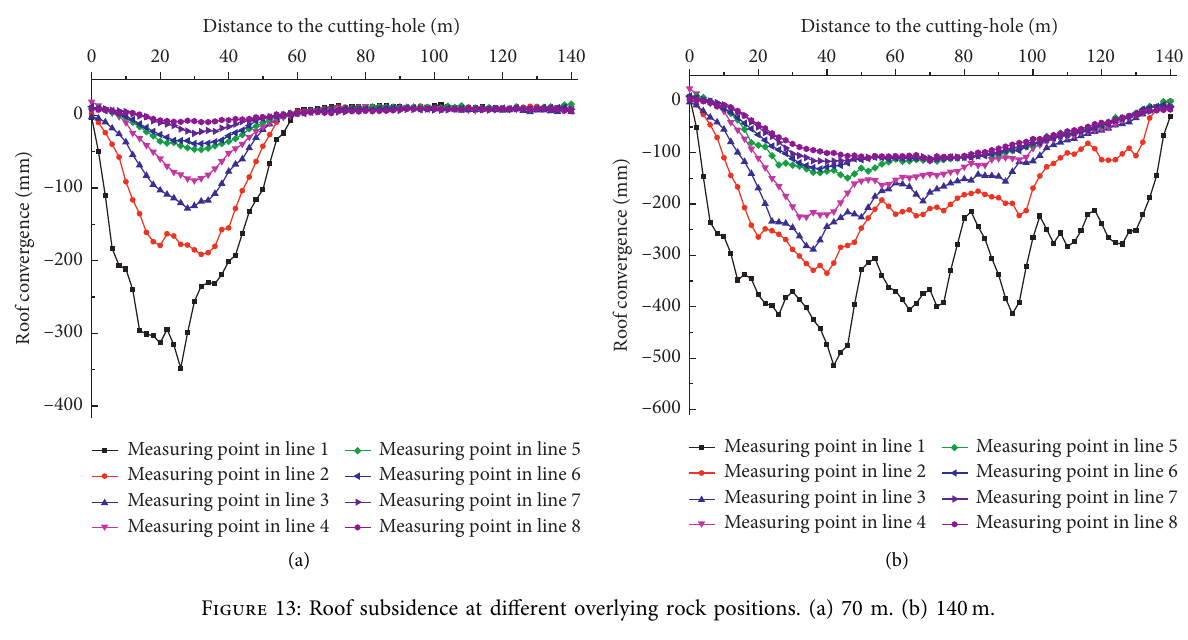
Figure 13: Roof subsidence at different overlying rock positions. (a) 70 m. (b) 140m.